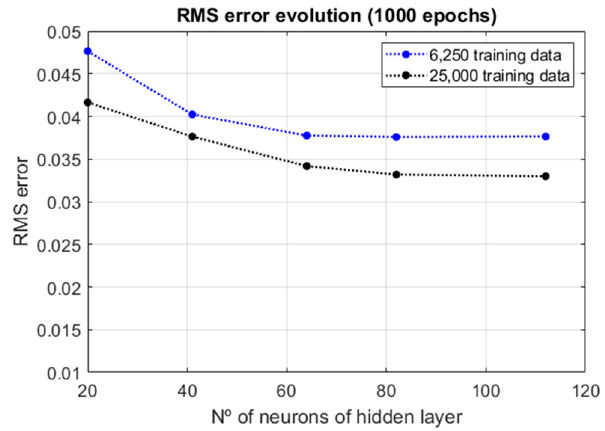
Figure 6. ANN with one hidden layer.